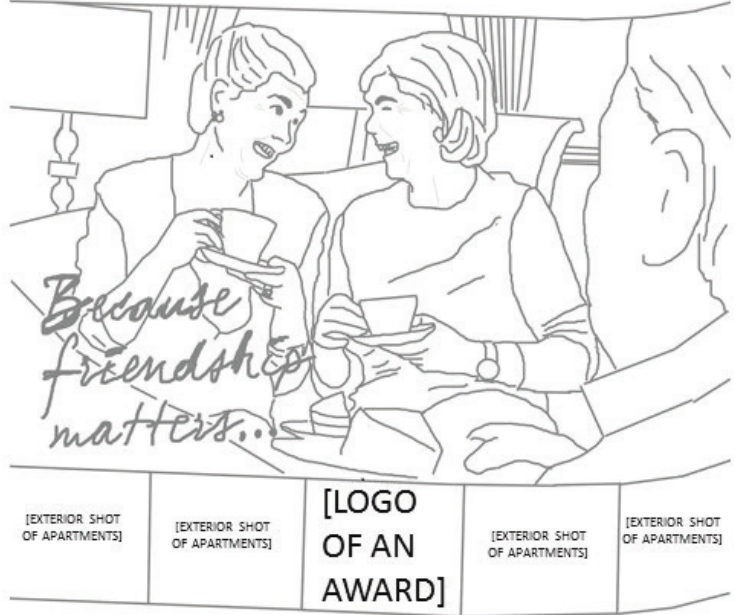
Figure 1. Example